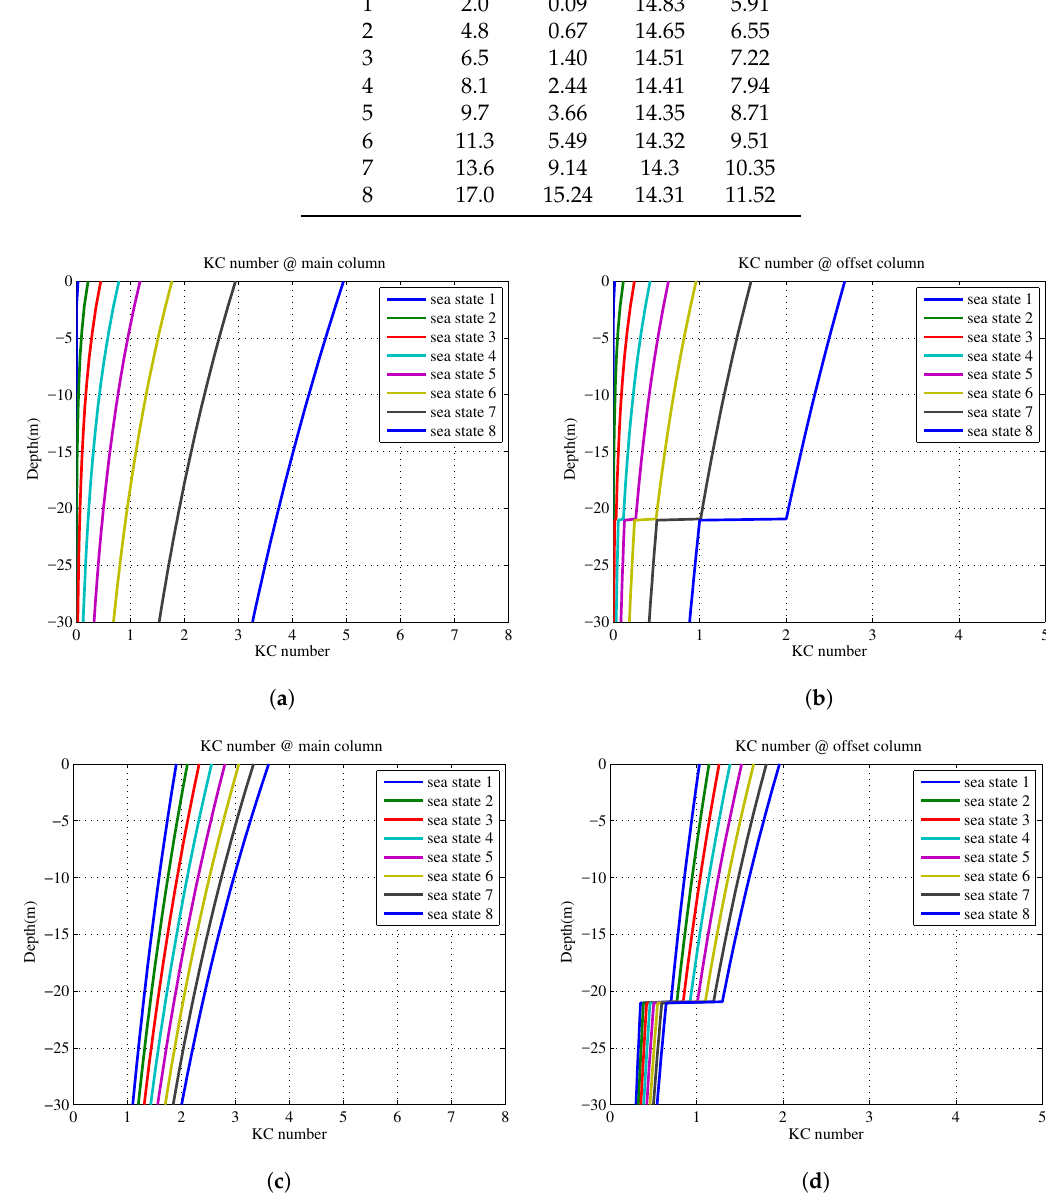
Figure 7. Keulegan–Carpenter (KC) numbers for the SNL semi-submersible platform: ( a ) for the main column at normal sea states; ( b ) for the offset column at normal sea states; ( c ) for the main column at 50-year return sea states; ( d ) for the offset column at 50-year return sea